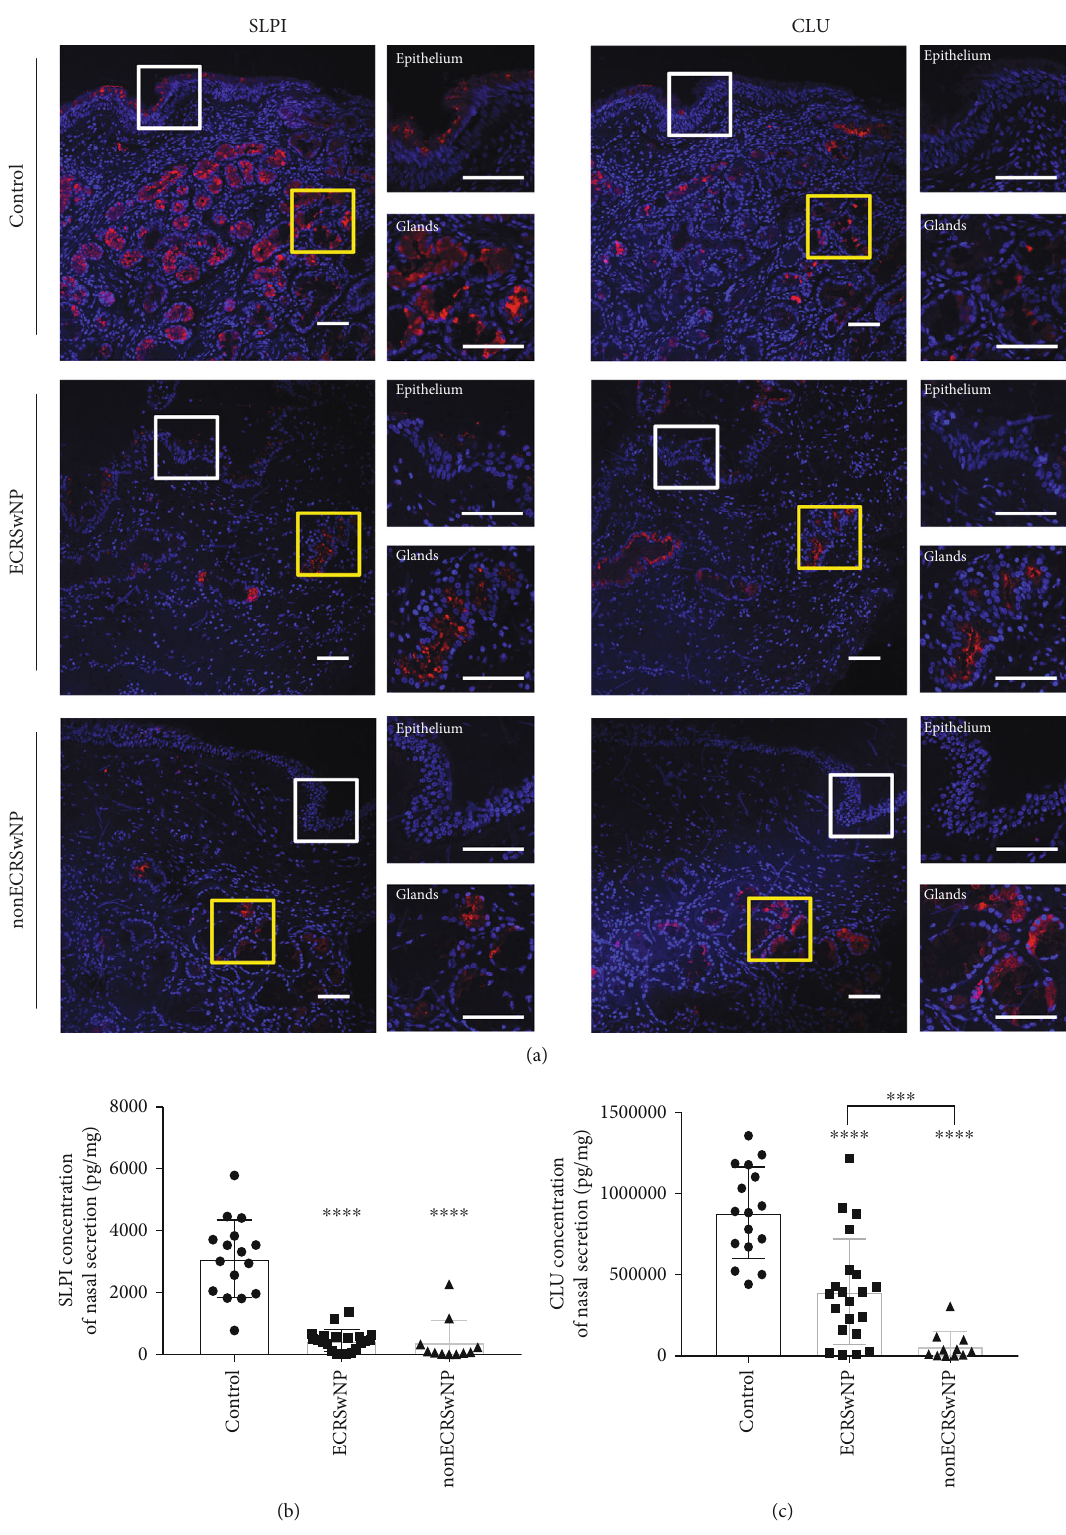
Figure 2: Expression of SLPI and CLU at the protein level in nasal tissues of CRSwNP. (a) Immuno fl uorescence staining of SLPI and CLU in nasal tissues from ECRSwNP, nonECRSwNP, and healthy controls. Epithelium area and submucosal glands were displayed at high magni fi cation. Bars = 25 μ m. (b, c) The expression of SLPI (b) and CLU (c) in nasal secretions of ECRSwNP, nonECRSwNP, and healthy controls detected by ELISA. ∗ P < 0 : 05 , ∗∗ P < 0 : 01 , and ∗∗∗ P < 0 : 001 . CRSwNP: chronic rhinosinusitis with nasal polyps; ECRSwNP: eosinophilic CRSwNP; nonECRSwNP: noneosinophilic CRSwNP; CLU: clusterin; SLPI: secretory leukoprotease